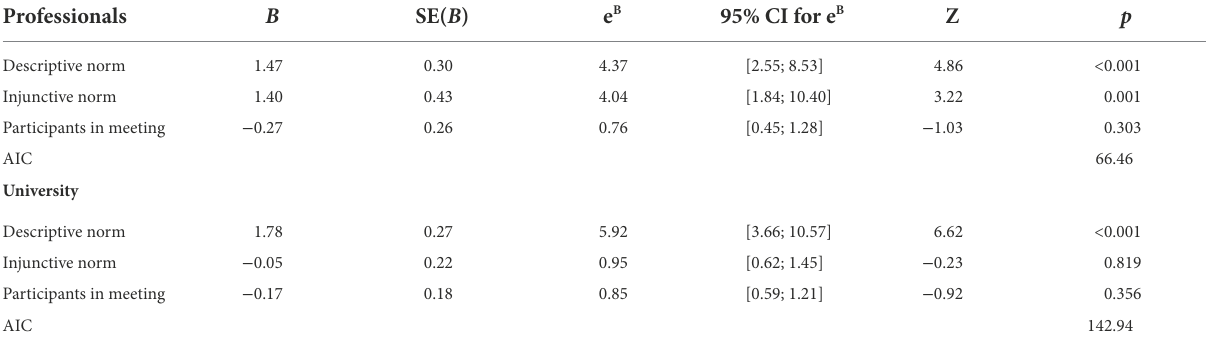
TABLE 3 Results of the logistic regression analyses for both groups.